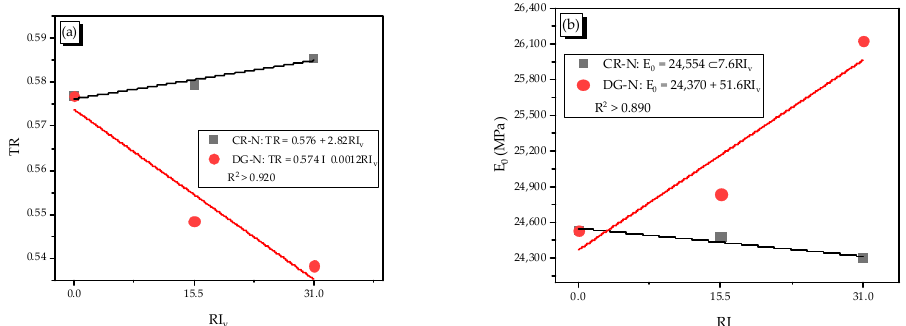
Figure 9. Relation of the reinforcing index–toughness ratio and elastic modulus in the non-heating case, ( a ) Relation between toughness ratio and reinforcing index in the non-heating case, ( b ) Relation between elastic modulus and reinforcing index in the non-heating case.